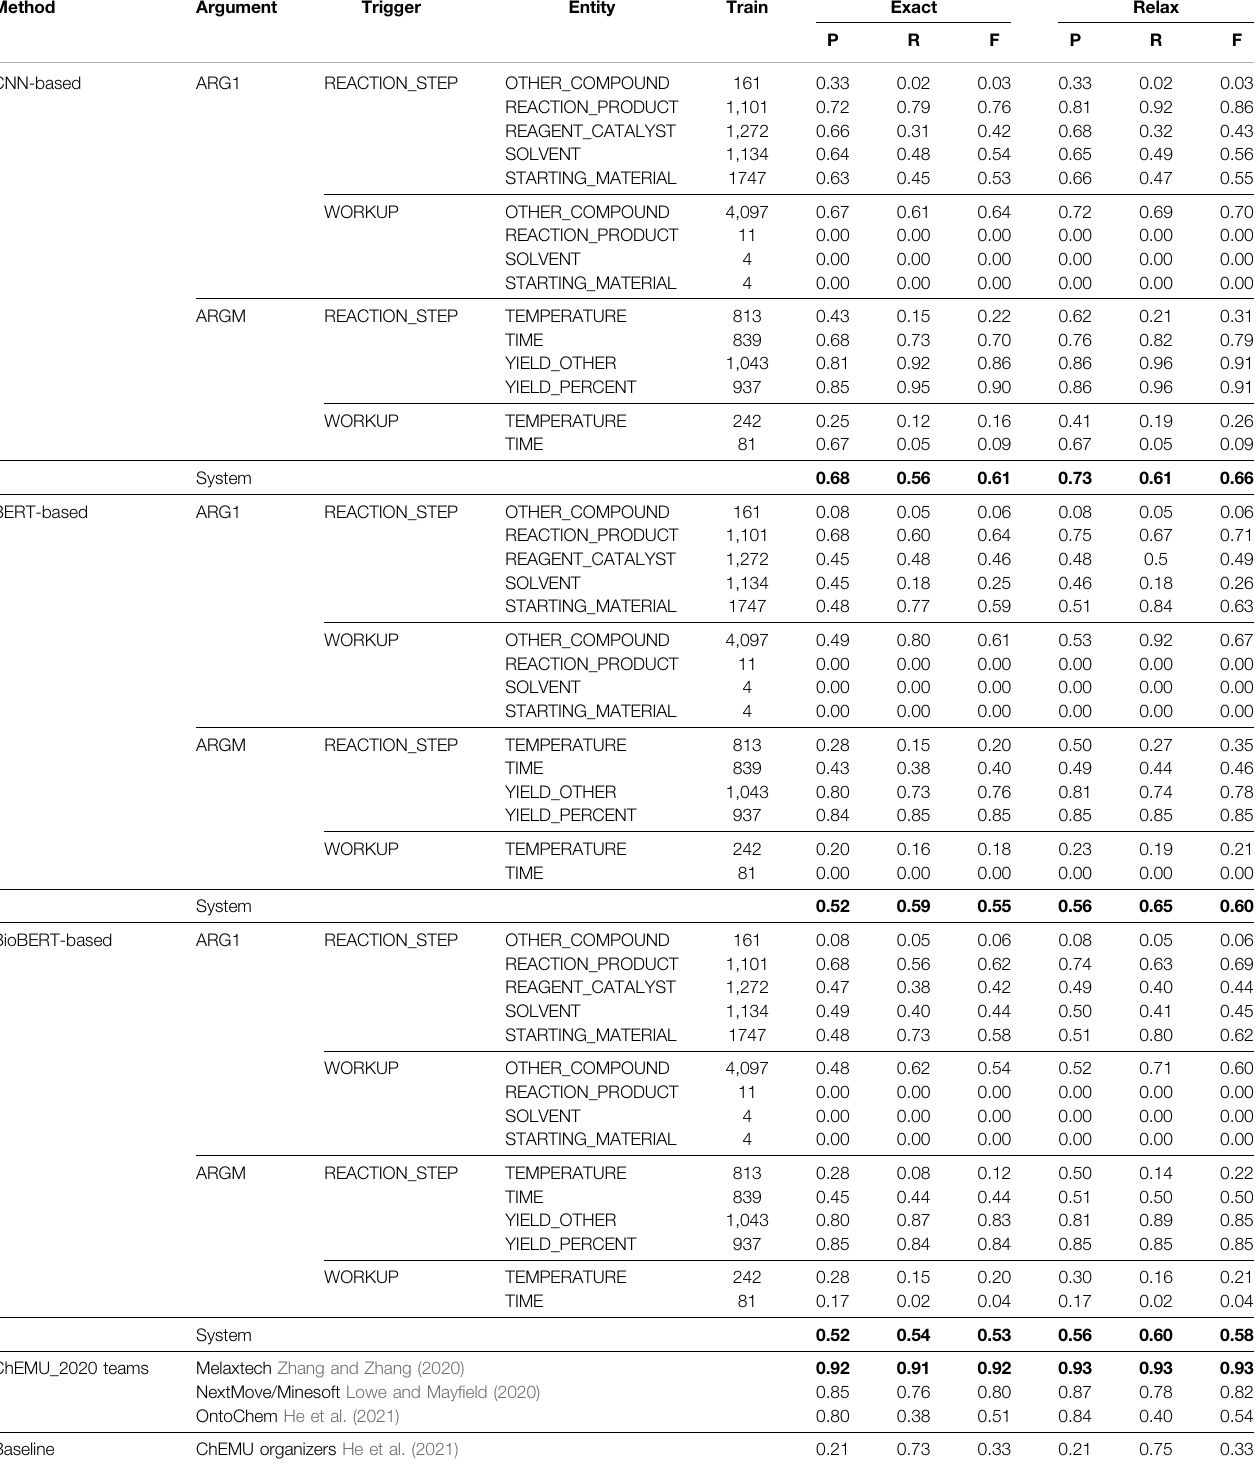
System performance of three methods (top 3 bold lines). The last bold line shows the best performance out of the chemu teams.